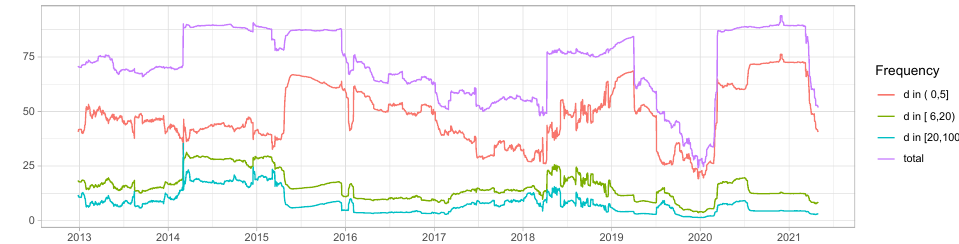
Figure 5. Dynamic frequency conditional connectedness. VARX